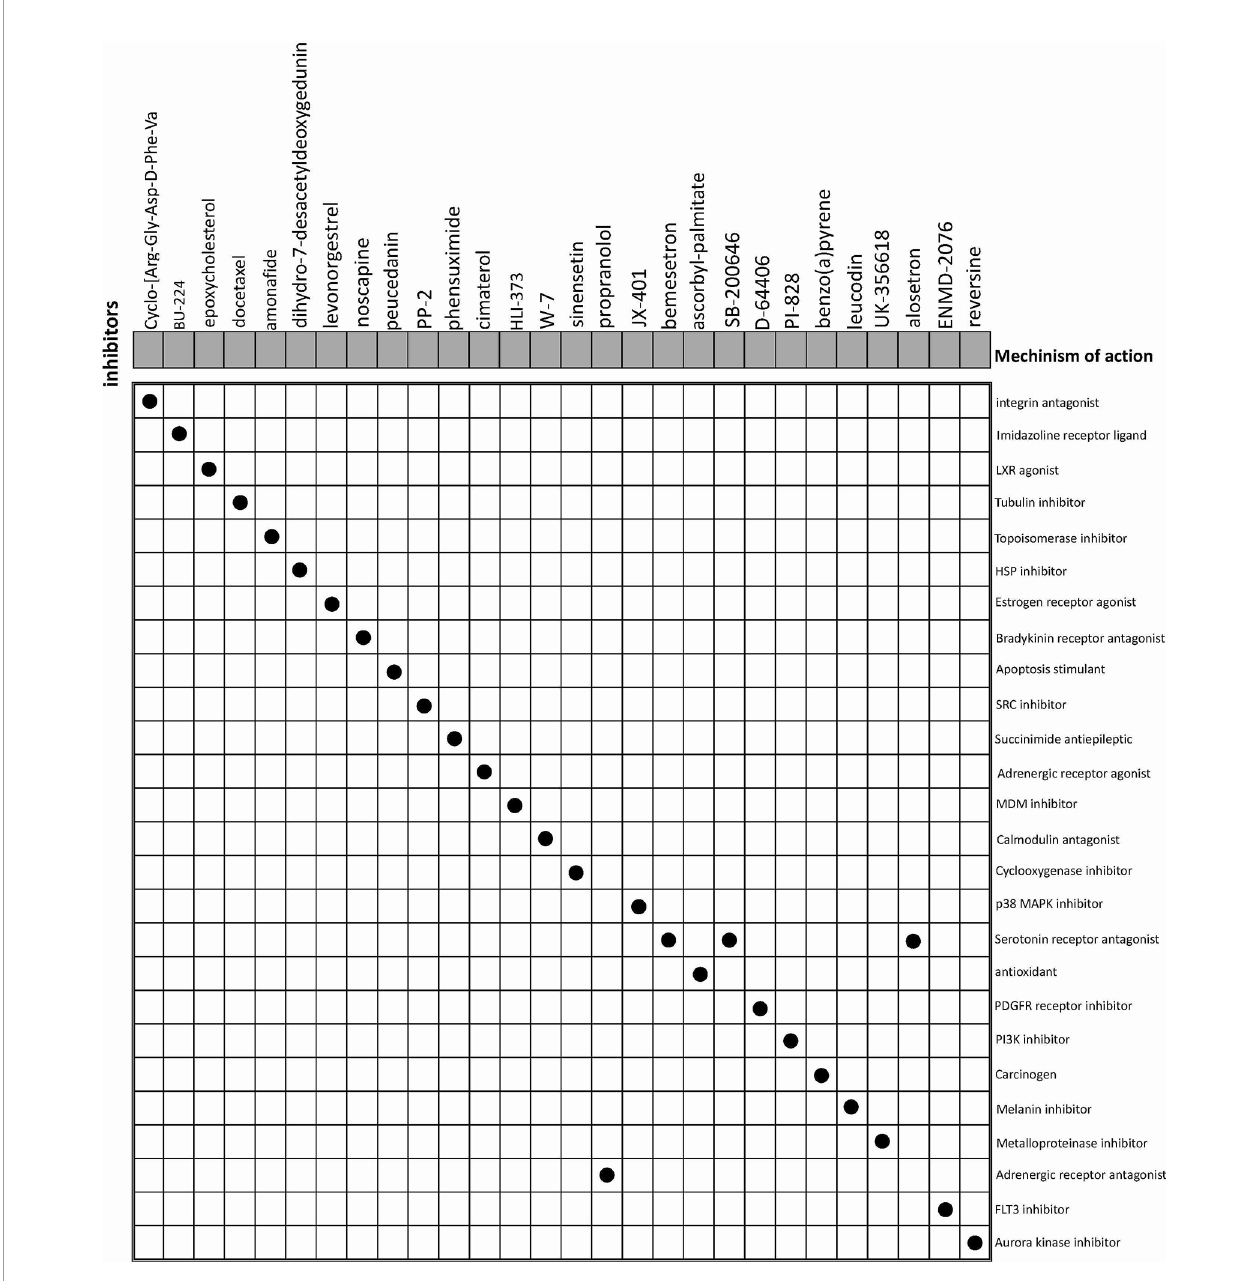
FIGURE 9 | CMap database analysis identi fi es potential cancidate small molecular drugs targeting the DEGs between high- and